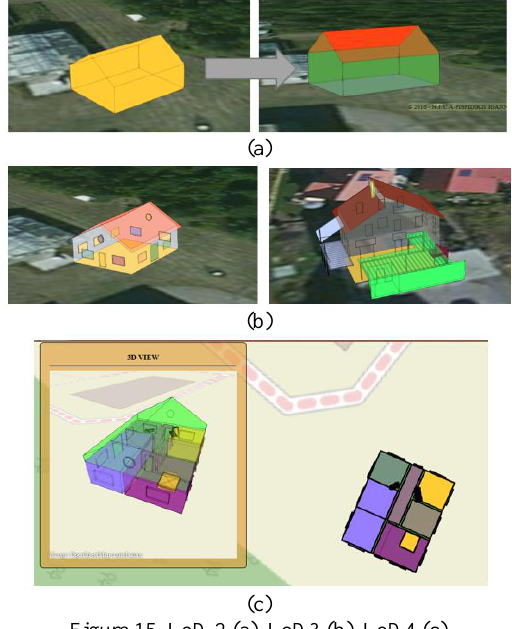
Figure 15. LoD 2 (a), LoD3 (b), LoD4